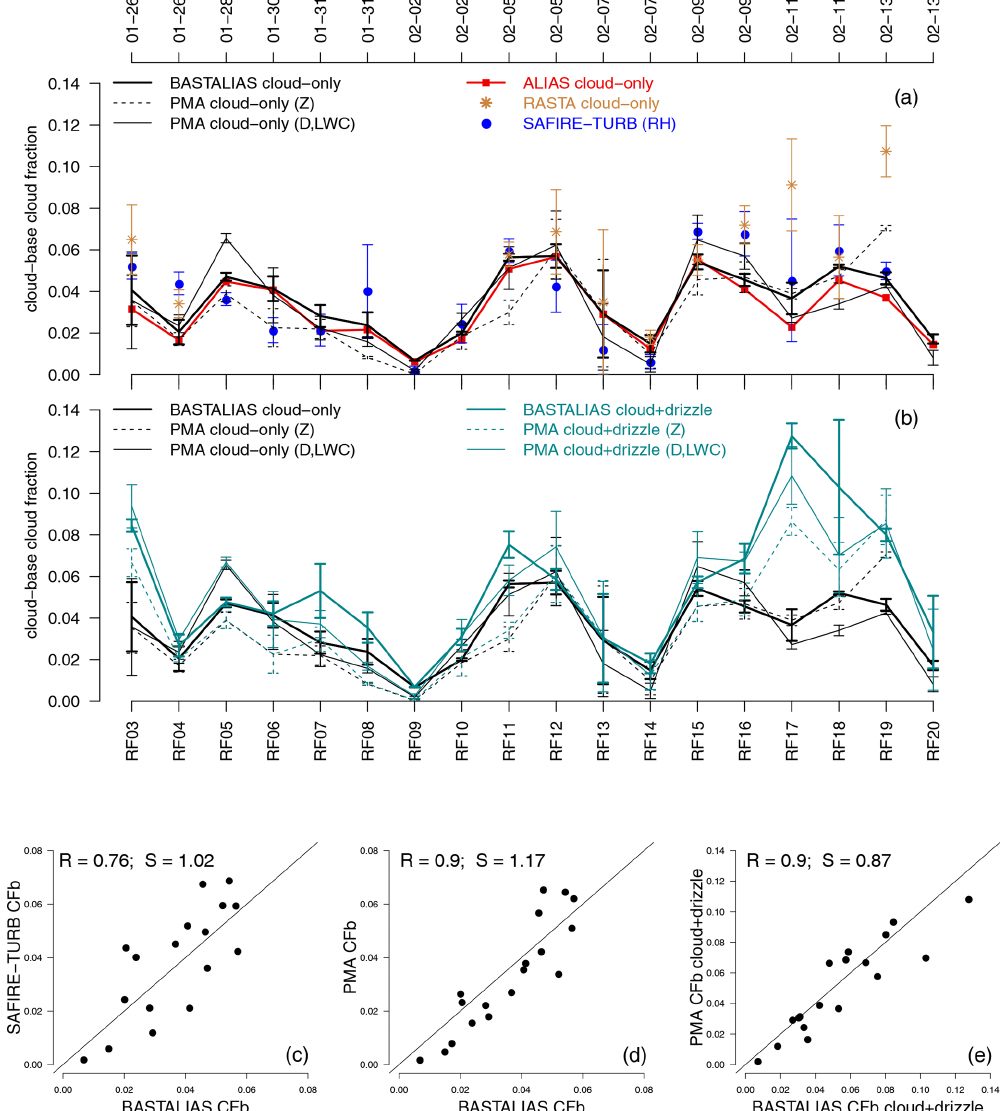
Figure 18. (a) Cloud base cloud fraction (CF b ) inferred from ATR observations across or along the R patterns flown at cloud base: from horizontal radar–lidar remote sensing (BASTALIAS), from horizontal lidar only (ALiAS), from in situ microphysical measurements (PMA) using an hydrometeor classification based either on ( D , LWC) or on reflectivities ( Z ) inferred from the particle size distribution, from in situ humidity measurements at the turbulence scale (RH from SAFIRE-TURB), and from the vertically pointing RASTA radar. (b) Comparison of the fractional area covered by “clouds only” (in black) or by “clouds+drizzle” (in color) inferred either from the BASTALIAS lidar–radar dataset or from the PMA dataset using both types of hydrometeor classification. Note that the time axis is not linear. (c, d, e) Correlation ( R ) and linear regression coefficient ( S ) between the CF b estimates derived from different ATR